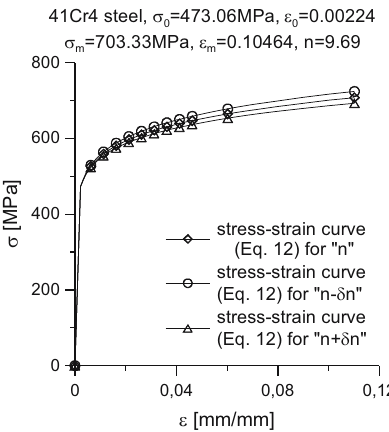
Figure A3: Comparison of the real stress – strain curve determined for the estimated value of the strain hardening exponent and the curves drawn based on the strain hardening exponent reduced or increased by the value of absolute ( zoom of the graph )